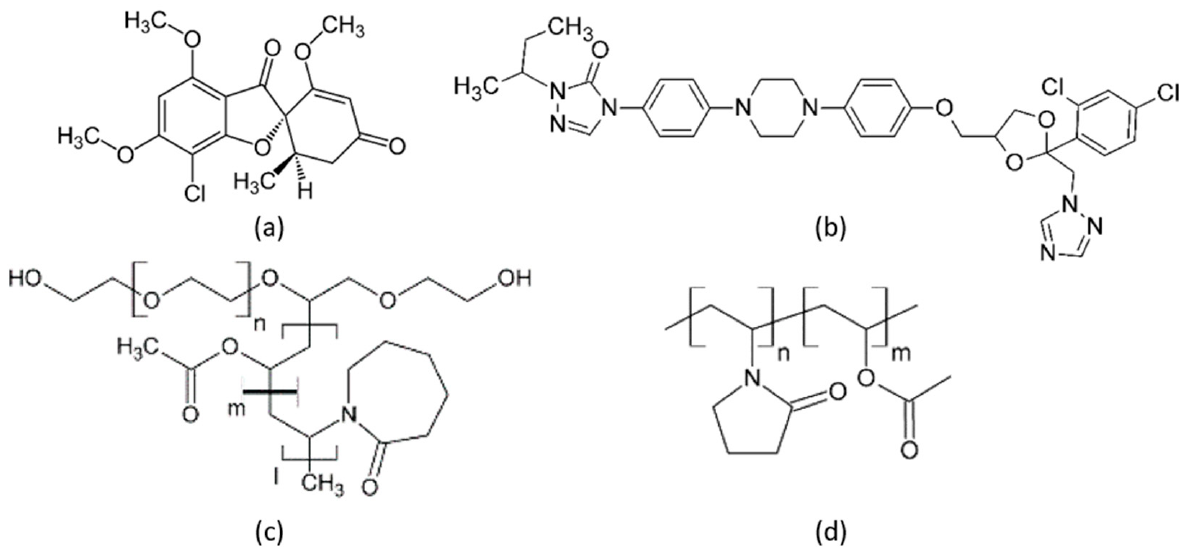
Figure 1. Chemical structures of ( a ) GRI, ( b ) ITR, ( c ) Soluplus ® , and ( d ) PVPVA. Determination of Particle-Size Distribution